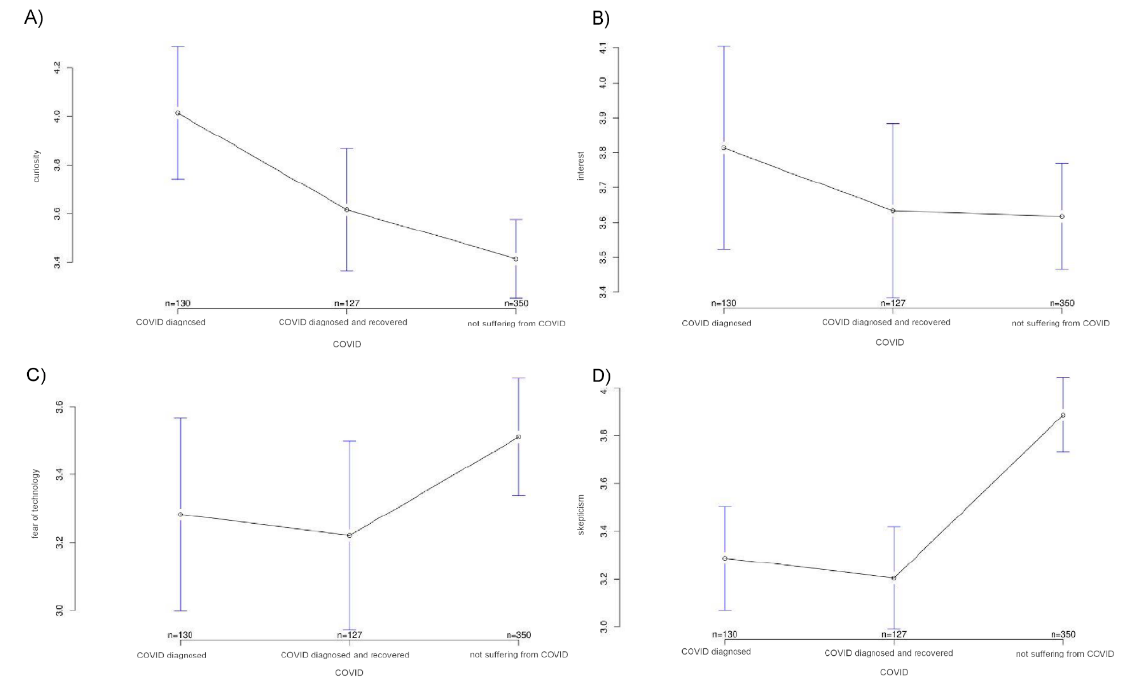
Figure 1. Average attitudes toward different aspects of technology acceptance in the three study groups. The y -axis shows the mean result of participants choice on the Likert scale: ( A ) Curiosity about the technology; ( B ) Interest in using it; ( C ) Fear of technology; ( D ) Skepticism about the technology.